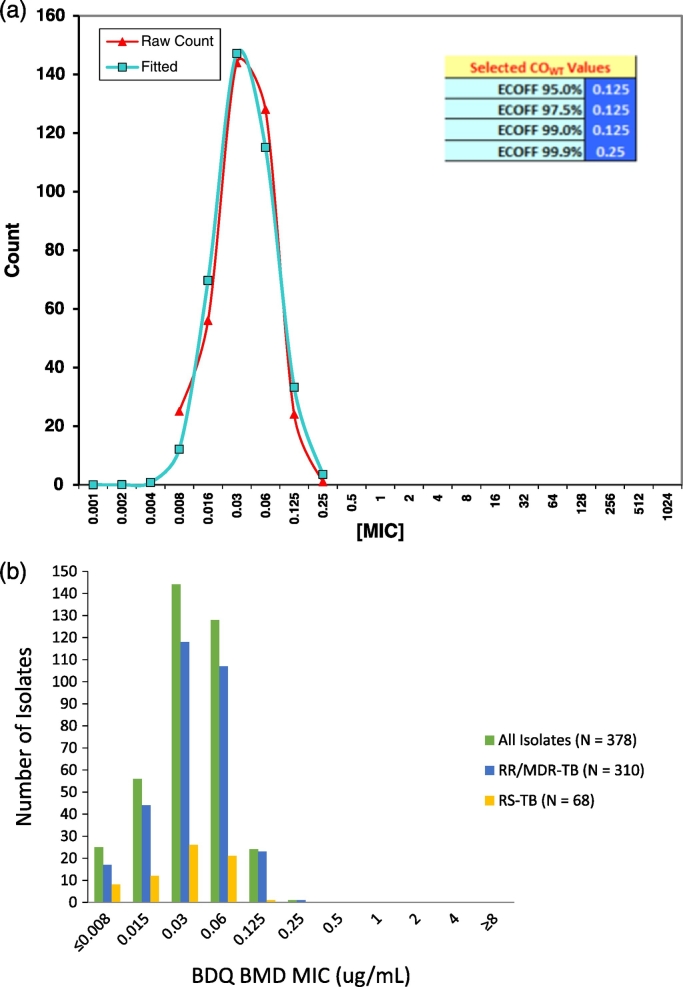
a: Wild-type ECV estimation using iterative non-linear regression on expanding subsets for BDQ on BMD (N = 378). b: Histogram of BDQ BMD MIC distribution (μg/ml), N = 378.